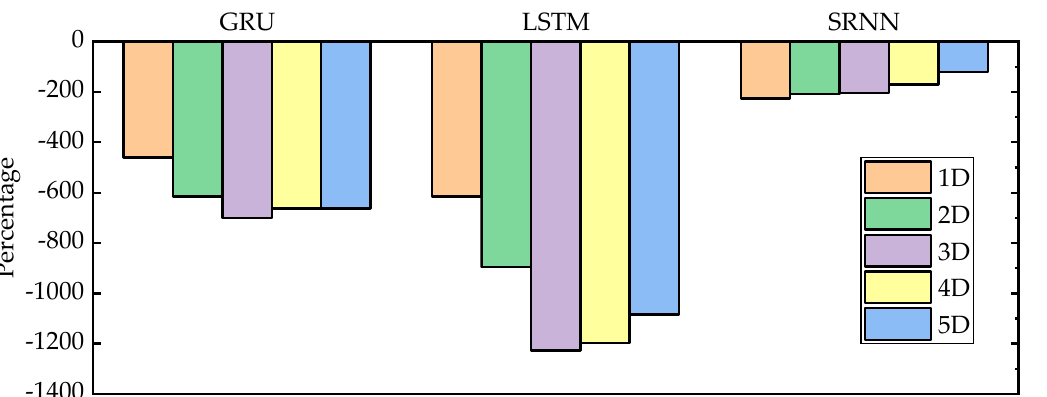
Table 4. Number of parameters of different